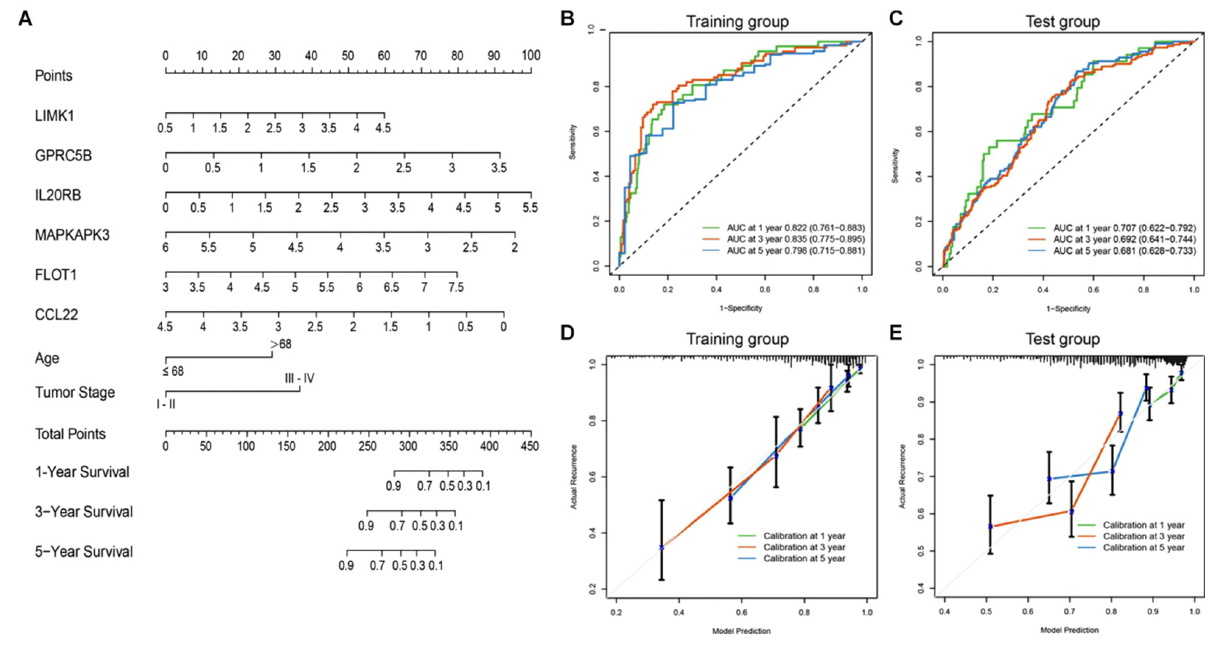
three independent, large-scale international genome databases for the exploration and validation of a prognostic IRG